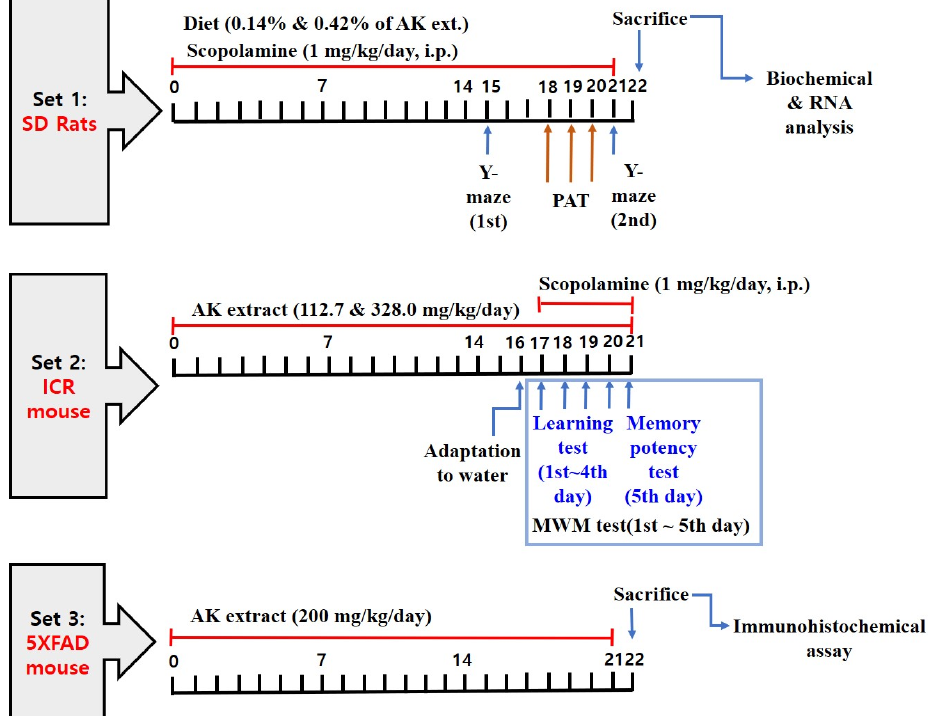
Figure 14. Schedule of animal experiments.